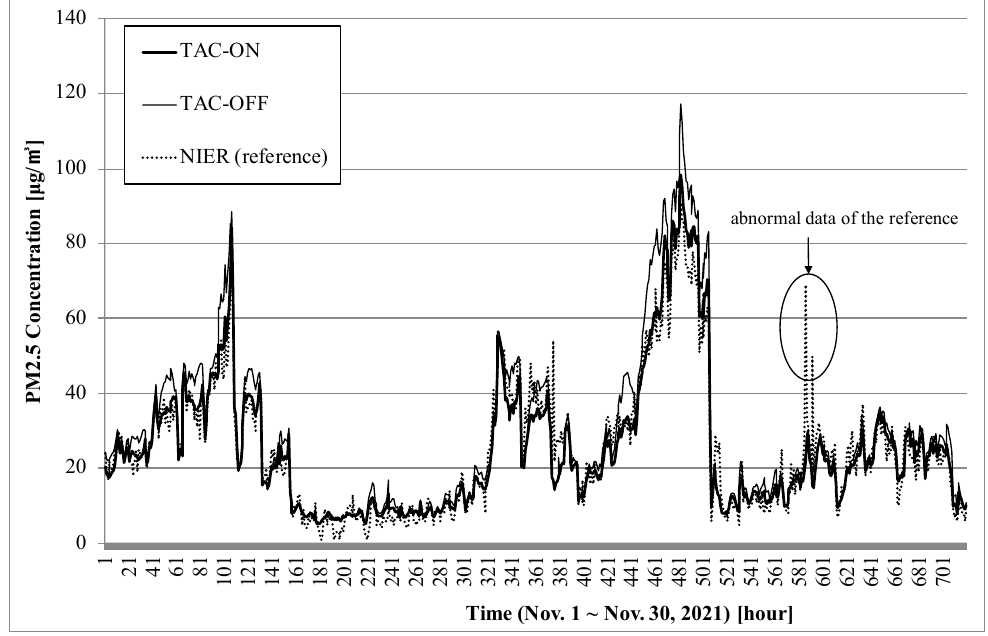
Figure 5. PM concentrations of two TAM devices with TAC-on and TAC-off from 1–30 November 2021.